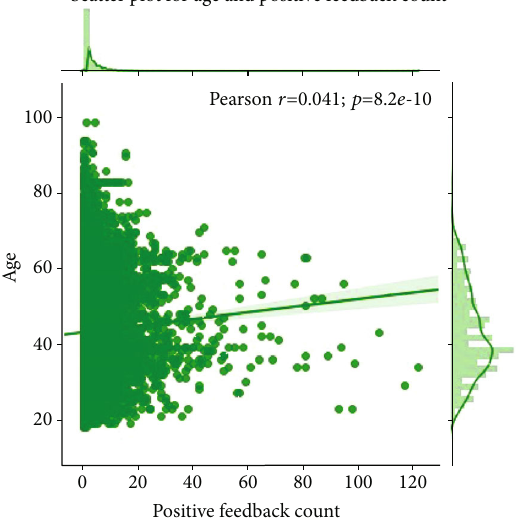
Scatter plot for age and positive feedback count